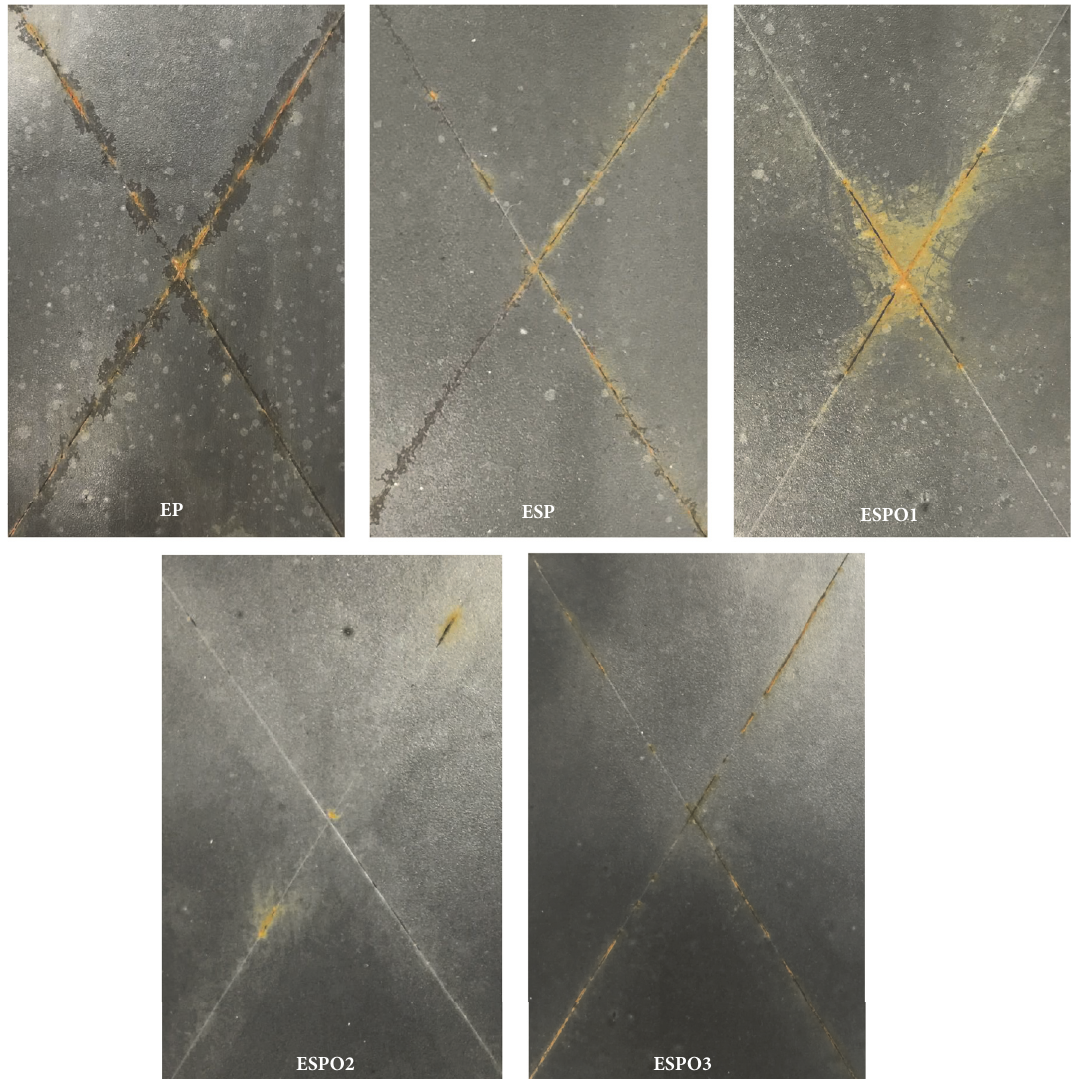
Figure 11: Photographs of coated steel panel exposed to salt spray for 28